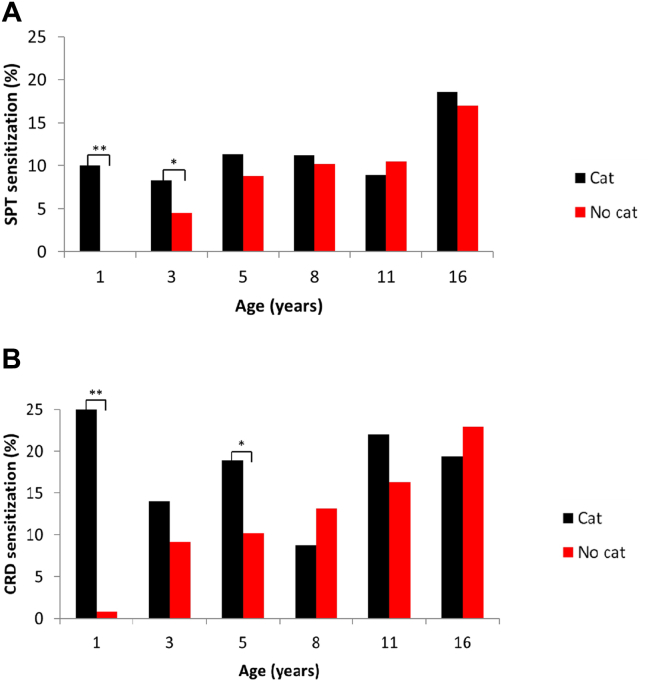
Cross-sectional association between cat ownership status during pregnancy and cat-specific sensitization (SPT, sIgE, CRD) during childhood. A, SPT sensitization. B, sIgE/CRD sensitization. *P < .05. **P < .001.